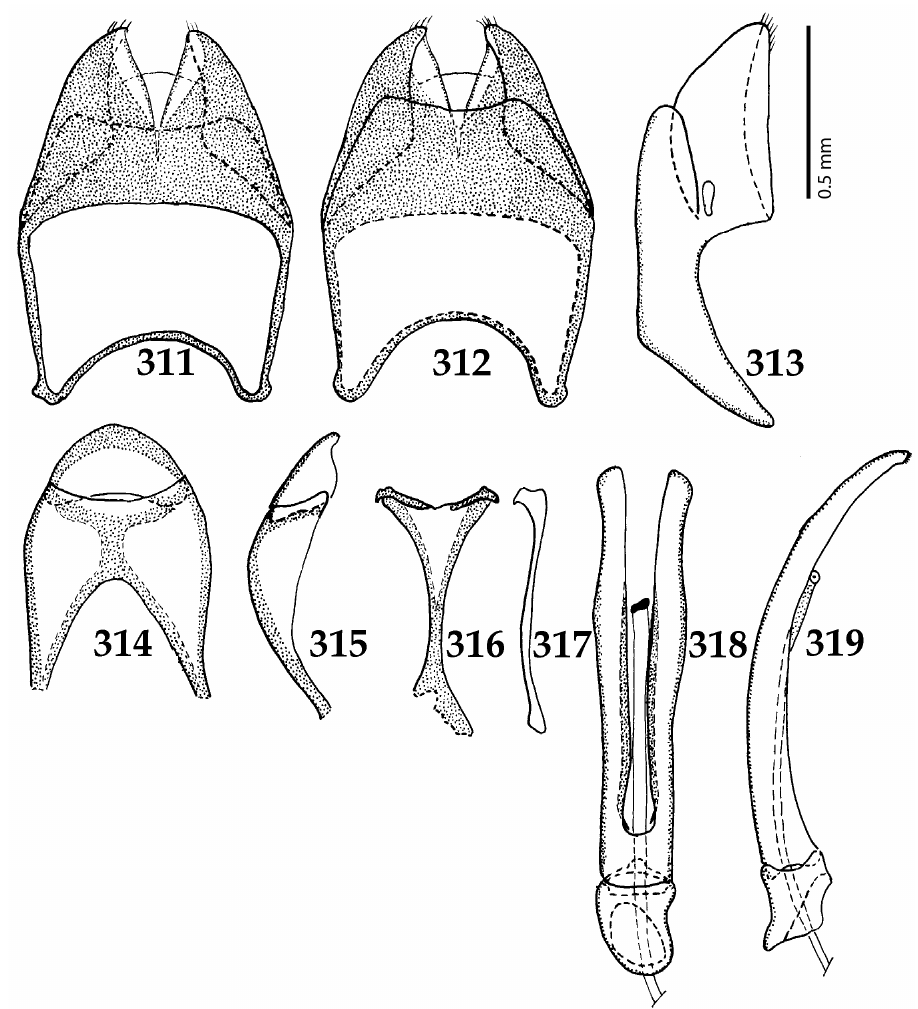
Figures 311–319. 311 Saprinus ( Saprinus ) amethystinus Lewis, 1900 male terminalia: 8 th sternite + 8 th tergite, ventral view 312 ditto, dorsal view 313 ditto, lateral view 314 male terminalia: 9 th + 10 th tergites, dorsal view 315 ditto, lateral view 316 male terminalia: spiculum gastrale, ventral view 317 ditto, lateral view 318 male terminalia: aedeagus, dorsal view 319 ditto, lateral